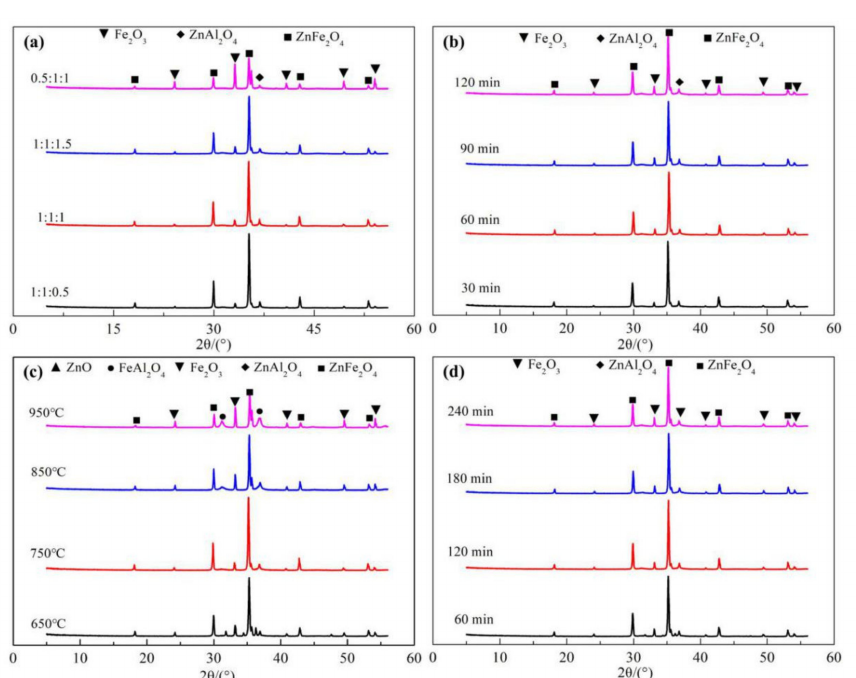
Figure 1. XRD patterns of roasted products under different conditions: ( a ) different ratio; ( b ) activation time; ( c ) roasting temperature; ( d ) roasting